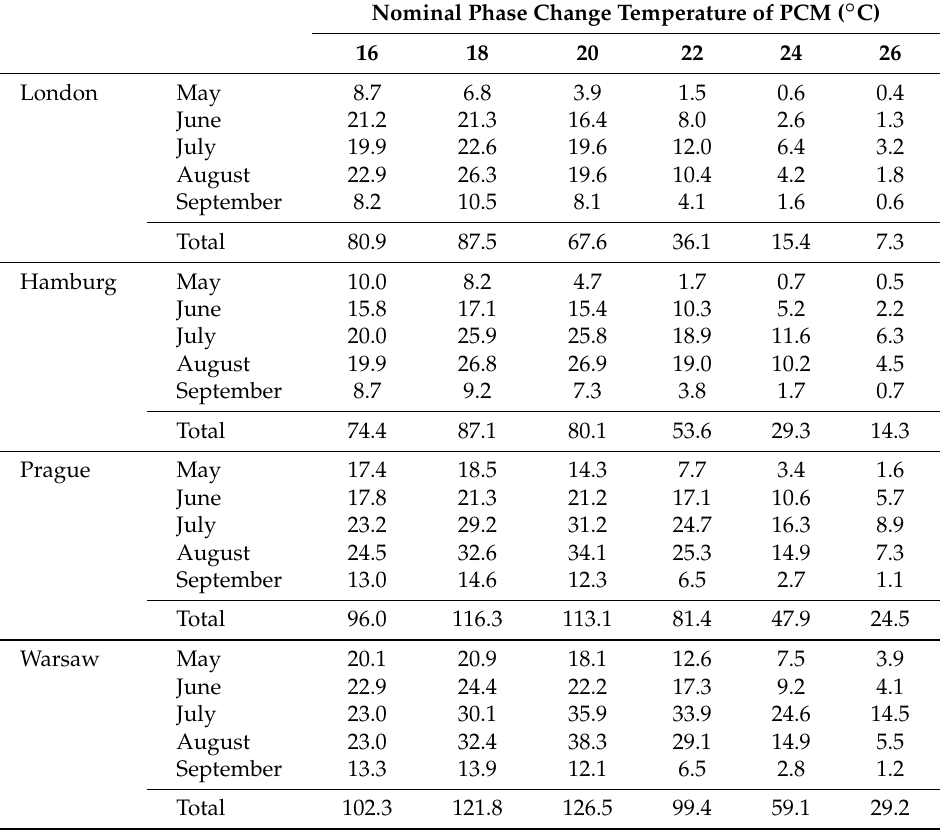
Table 3. Energy saving potential in kWh (cities between 50 ◦ N and 55 ◦